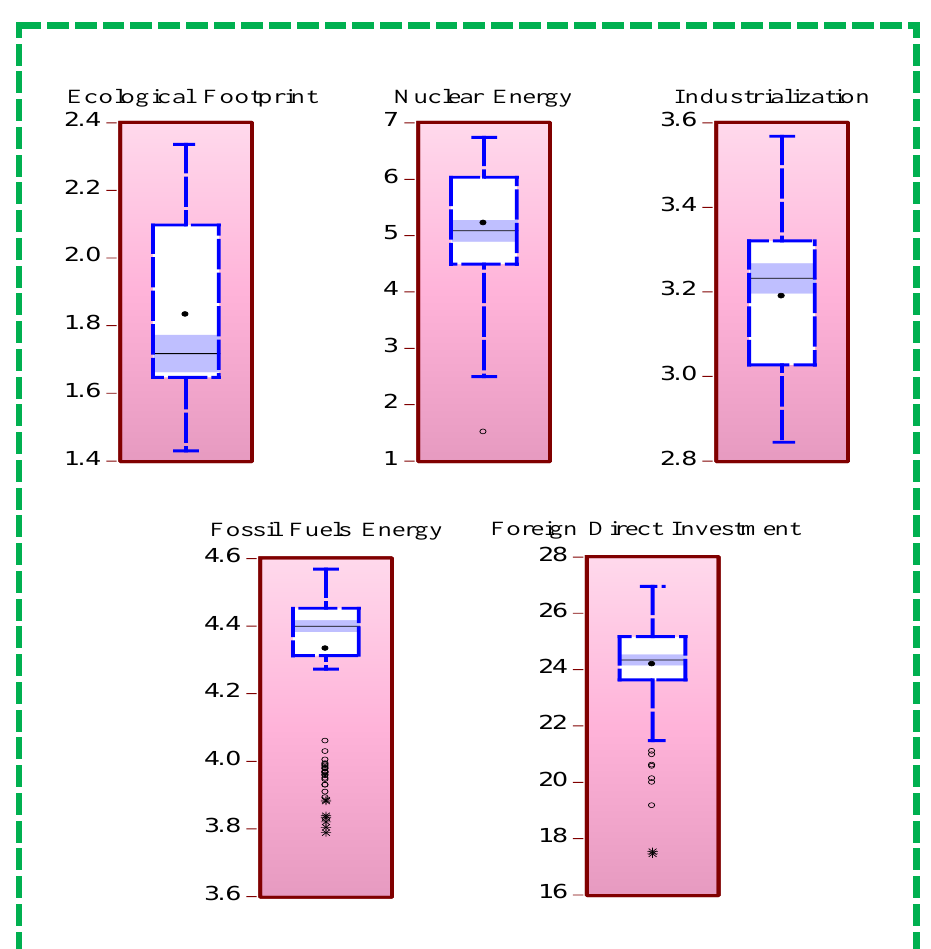
Figure 3. Box chart of the selected variables.